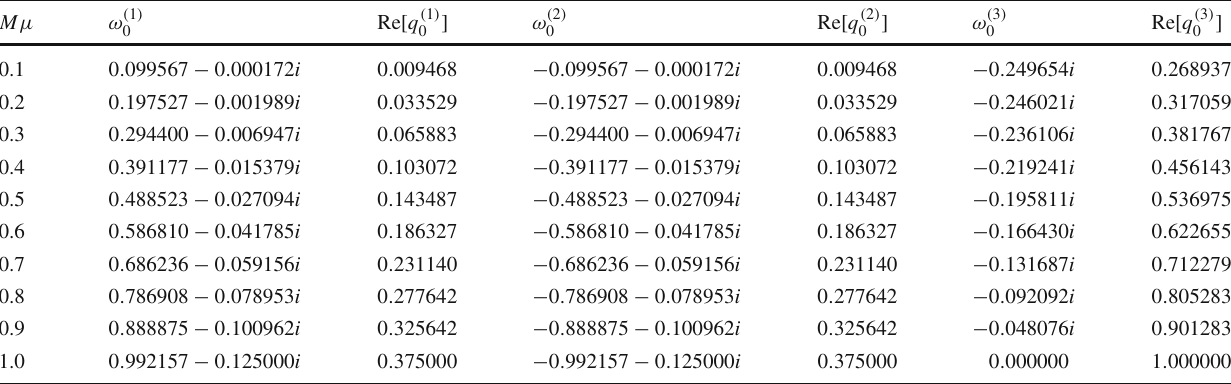
Table 1 Values of the resonant frequencies ω for 0 . 1 ≤ M μ ≤ 1 . 0. We focus on the fundamental mode N =